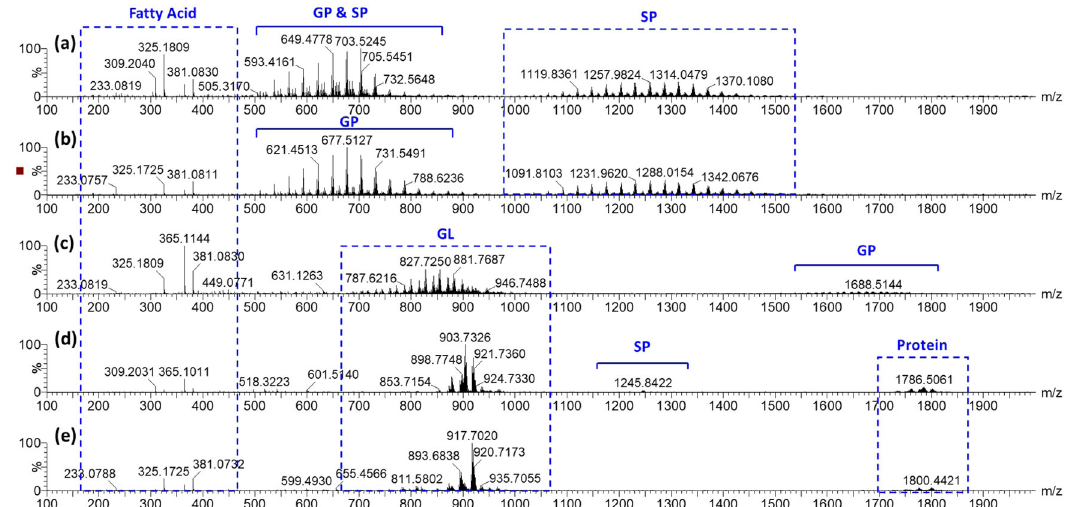
Fig. 3 Mass spectra. a cow milk, b goat milk, c camel milk, d oat milk, and e soya milk samples with DESI-MS.